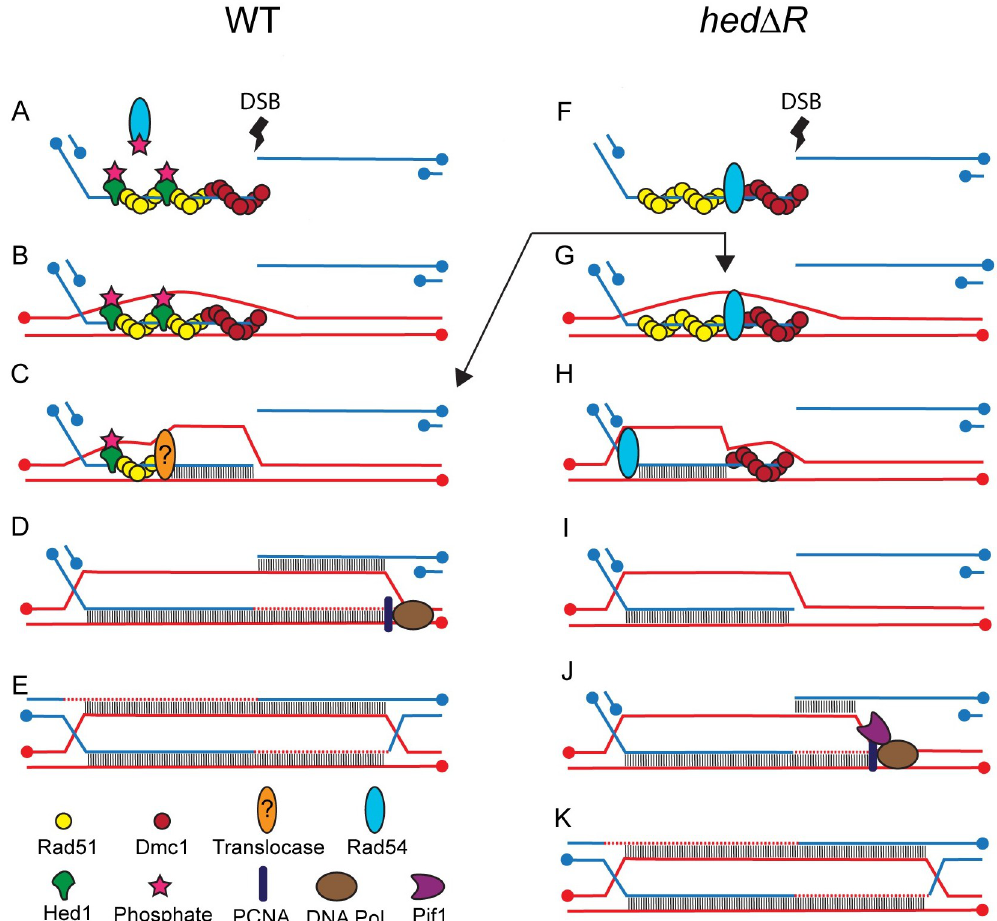
Fig 9. Model for Rad51-mediated interhomolog crossovers during meiosis. (A) Presynaptic filament shown for one side of a DSB in WT cells. Blue lines represent the duplex of one homolog while red lines represent a chromatid from the other homolog. Dots indicate the 5’ ends of the DNA. (B) Nascent D-loop or paranemic joint. (C) Conversion to a mature D-loop by removal of Dmc1 and heteroduplex formation between the invading strand and donor strand of opposite polarity. The question mark indicates that the mechanism for how this occurs is unknown. (D) Extension of the D-loop by DNA synthesis by Pol δ -PCNA followed by second end capture. (E) Double Holliday junction. (F) Presynaptic filament shown for one side of a DSB in hed Δ R cells with Rad54 interacting with Rad51. (G) Nascent D-loop or paranemic joint. (H) Internal D-loop created by Rad54 removal of Rad51 and heteroduplex formation between the invading strand and donor strand of opposite